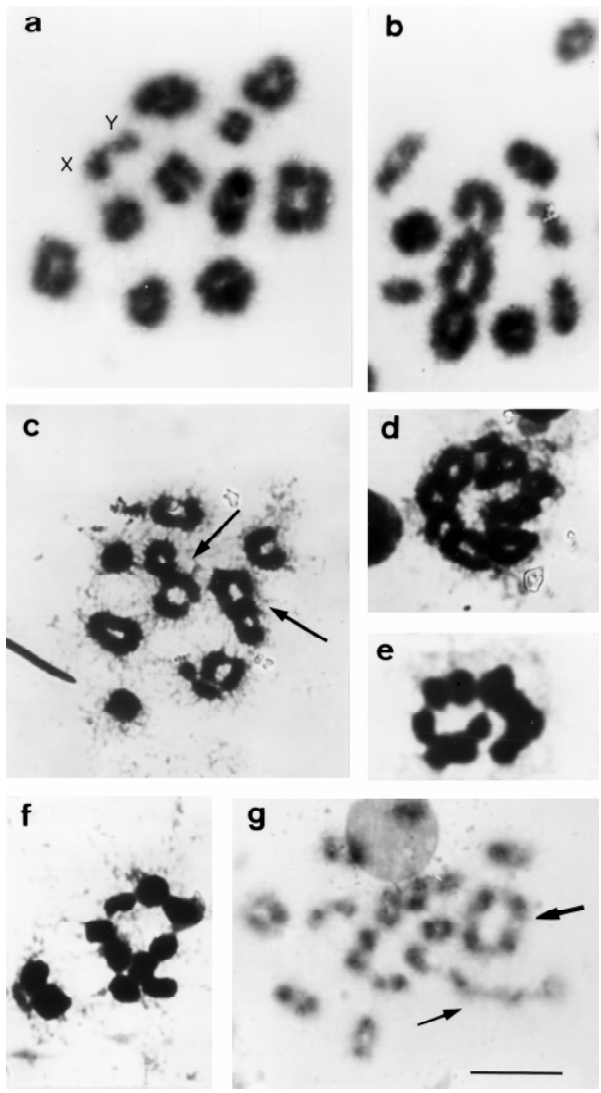
Figure 1 - Meiotic chromosomes of specimens of Physalaemus petersi be- longing to karyological group I, stained with Giemsa ( a-f ) (bar = 10 m m) or C- banded ( g ) (bar = 10.3 m m). In a , the 11 bivalents from one spermatocyte of specimen ZUEC 9595 showing no association between them; the sex chro- mosomes XY are indicated. In b , another spermatocyte from the same speci- men showing three associated bivalents. In c , two alternate quadrivalents (arrows) from specimen ZUEC 9588. In d-f , multivalents involving a great number of bivalents from specimens ZUEC 9588 (d, f) and ZUEC 9589 (e). In g , C-banded chromosomes from specimen ZUEC 9586. The adjacent quadriva- lent (large arrow) and the linear chain (small arrow) are shown. Note also the absence of heterochromatin in the regions of